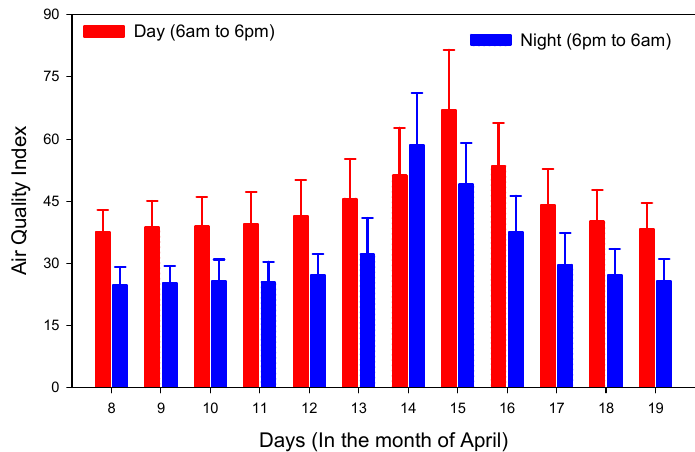
Figure 13. Air quality index for pre ‐ , post ‐ , and Vishu episode.